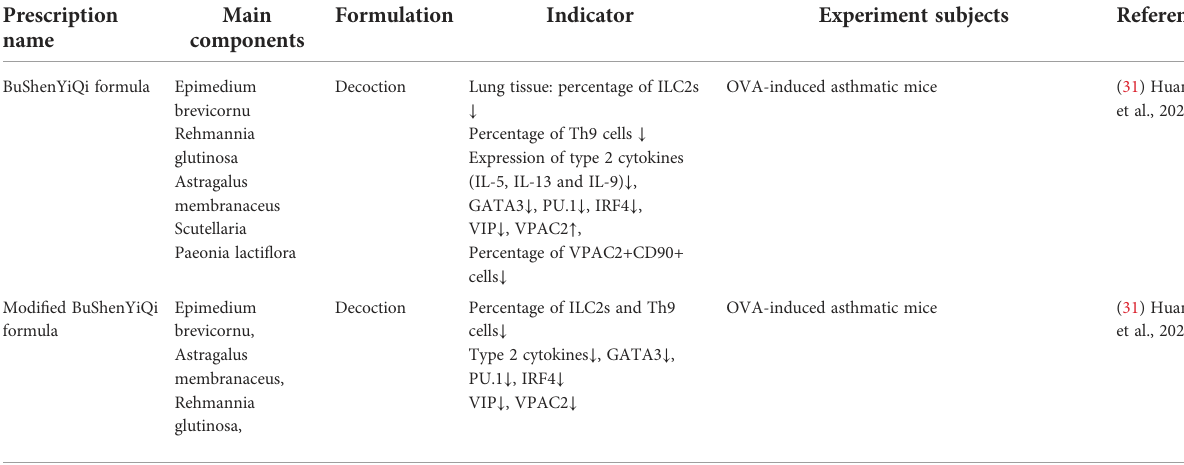
TABLE 2 The prescription, composition, formulation, and mechanism of asthma treatment. Prescription